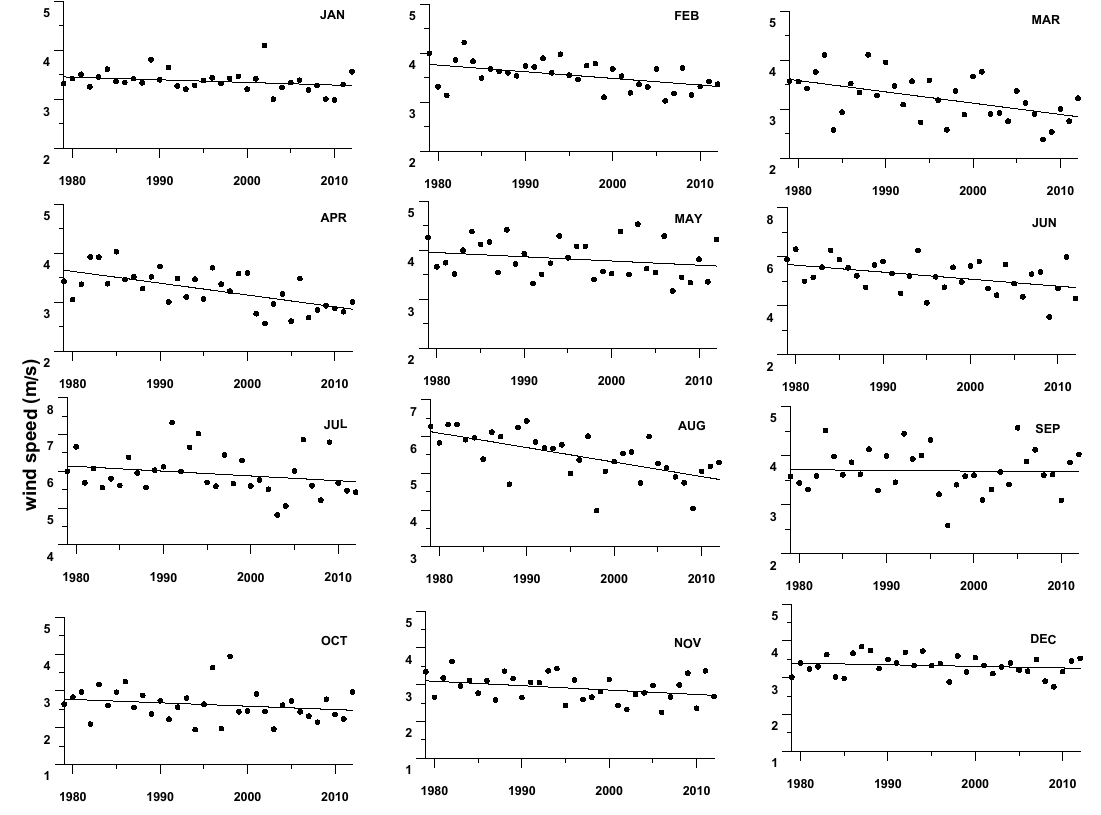
Figure 4. Temporal variation in monthly mean wind speed from 1979 to 2012. 459 460 Table 2. Frequency of occurrence of wind speed in different